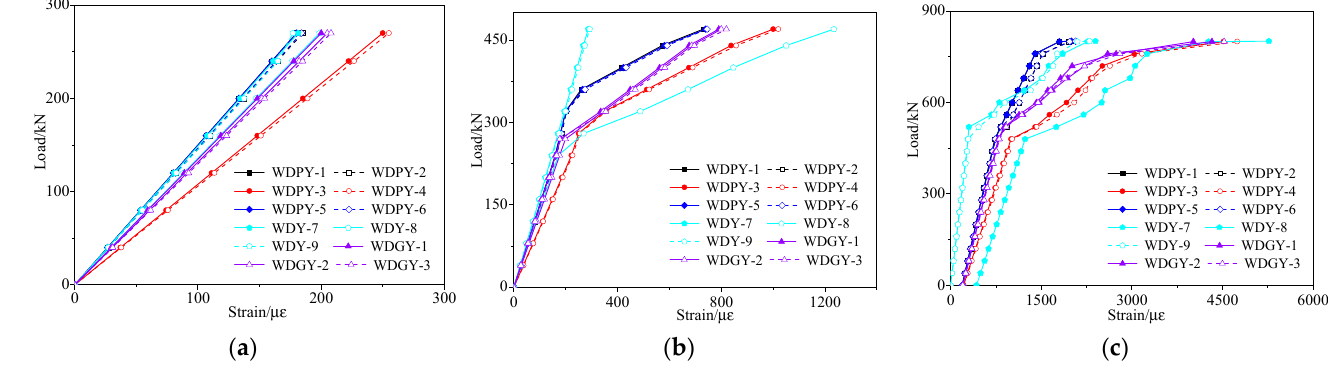
Figure 21. Strain vs. load curves of the repaired #3-2 girder strengthened by steel plates. ( a ) Elastic stage; ( b ) Working stage with cracks; ( c ) The failure stage.